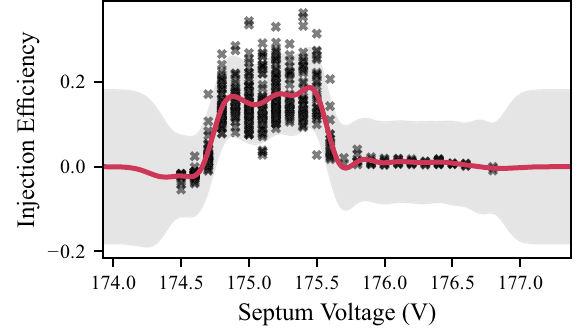
FIG. 1. Example of a parameter scan measurement of the septum magnet voltage, where all other accelerator tuning parameters are kept constant during the scan. The GP hyper- parameters f l i ; σ 2 g are fitted to the measured data points (crosses) via a log-likelihood fit. The solid line depicts the GP posterior mean and the shaded region shows the 95% confidence